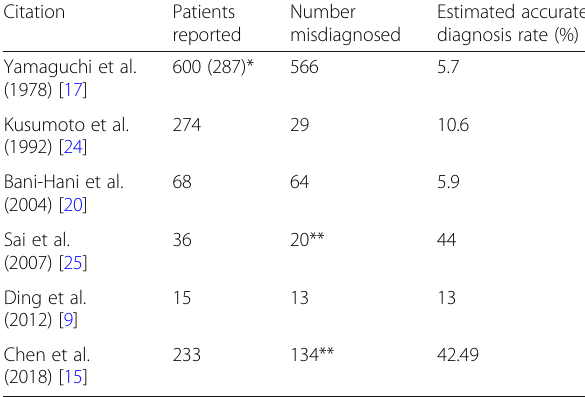
Table 1 Estimated rates of accurate diagnosis